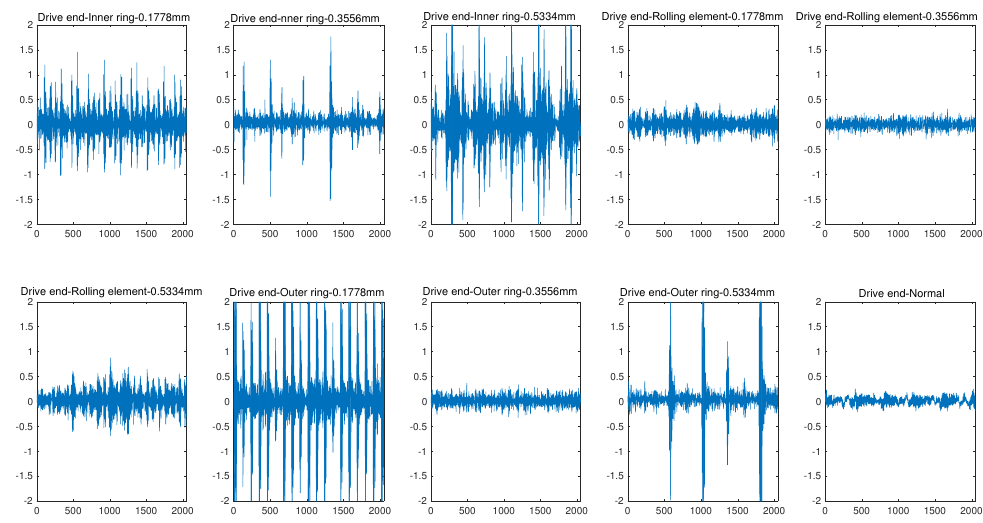
Figure 1. Time frequency diagram of failure samples at drive